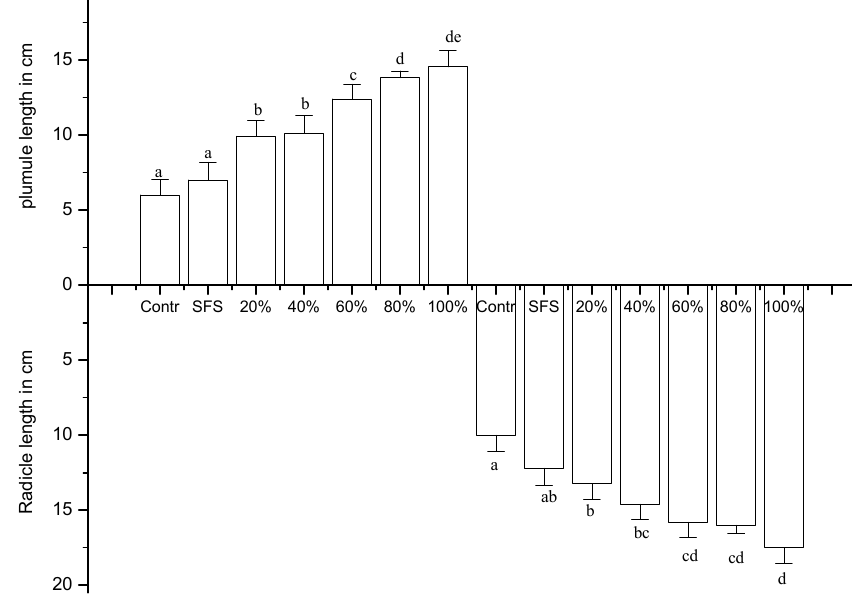
Figure 11. Effect of EF-LSEs on growth parameters of tomato seedling and plant height. The height of the tomato seedlings at the end of five days was 5.4 cm ( F 6,28 = 30.98; p < 0.005), with radicle and plumule lengths of 4 cm ( F 6,28 = 42.16; p < 0.005) and 3 cm ( F 6,28 = 42.94; p < 0.005), respectively (Figure 12), with 1.26 radicle: plumule ratio ( F 5,24 = 32.20, p < 0.005) (Figure 13).